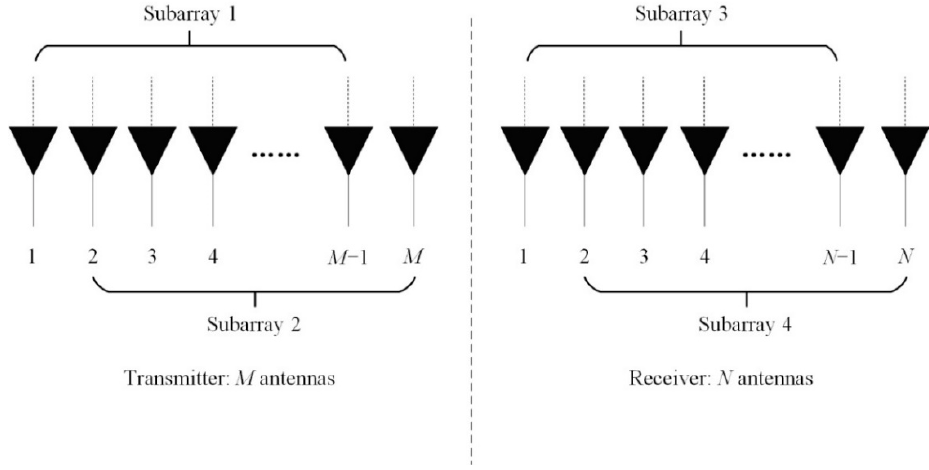
Figure 2. The division of the transmitting array and receiving array.